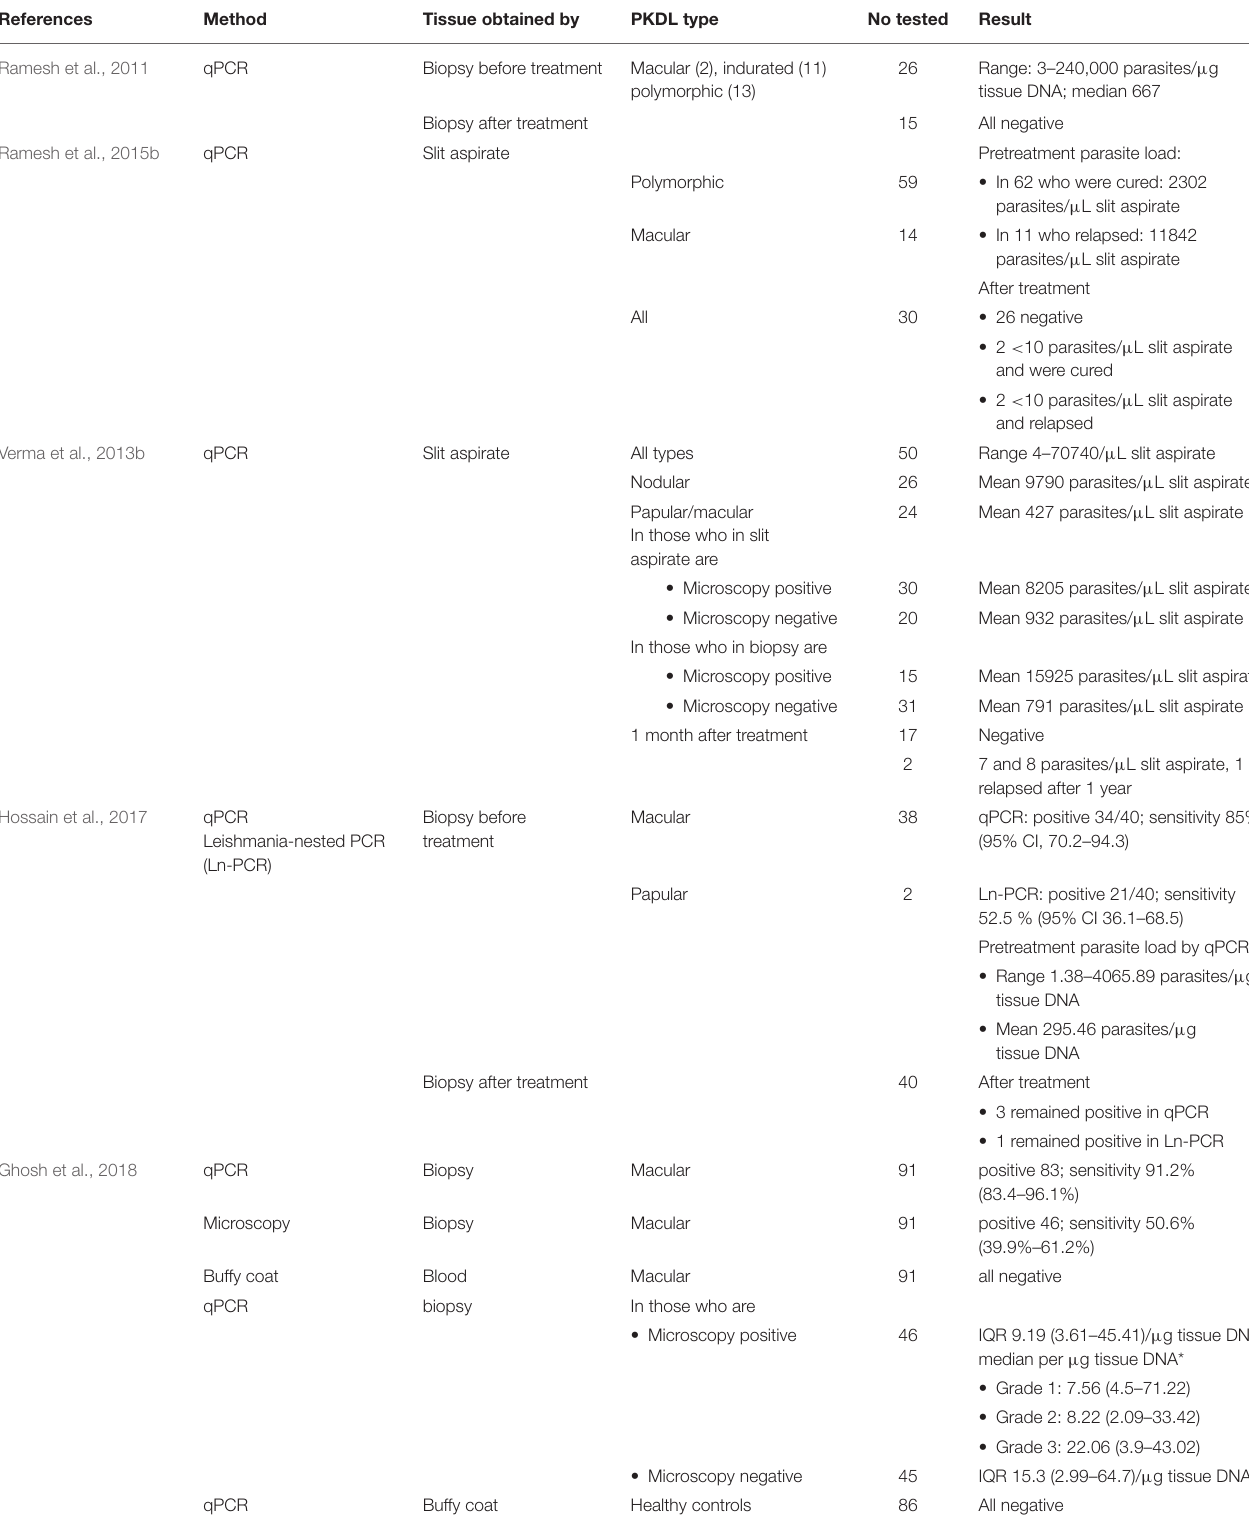
TABLE 2 | Summary of studies that use qPCR in diagnosis of PKDL, including those that use qPCR during